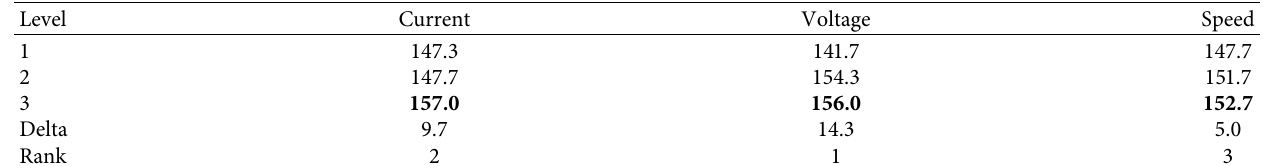
Table 7: Response table for means for hardness of WZ.